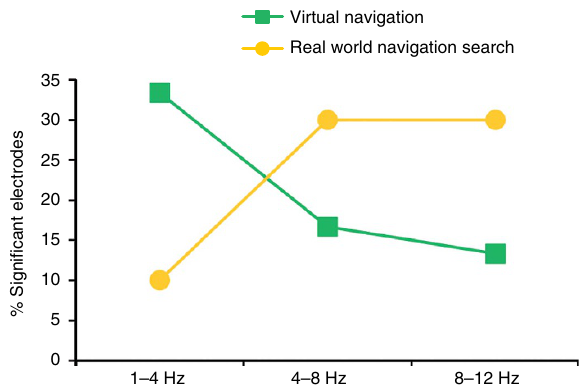
Figure 3 | Electrode contacts showing significant differences between movement and stop periods. Significant electrode contacts are depicted as the percentage of total electrode contacts across the established frequency bands.